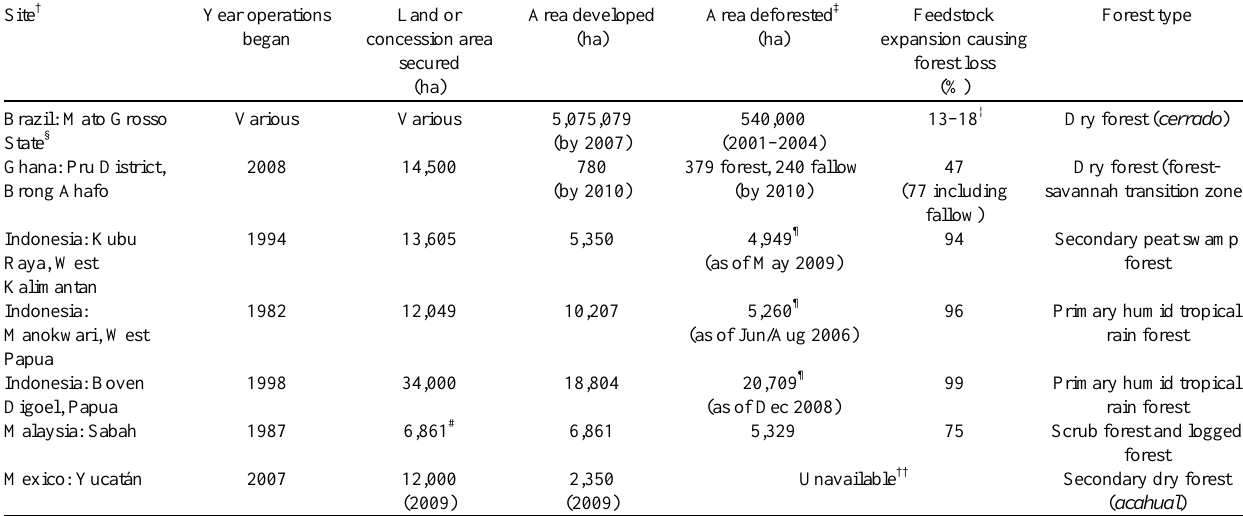
Table 1. Summary of direct land-use changes associated with industrial-scale feedstock expansion in the case study sites. Site